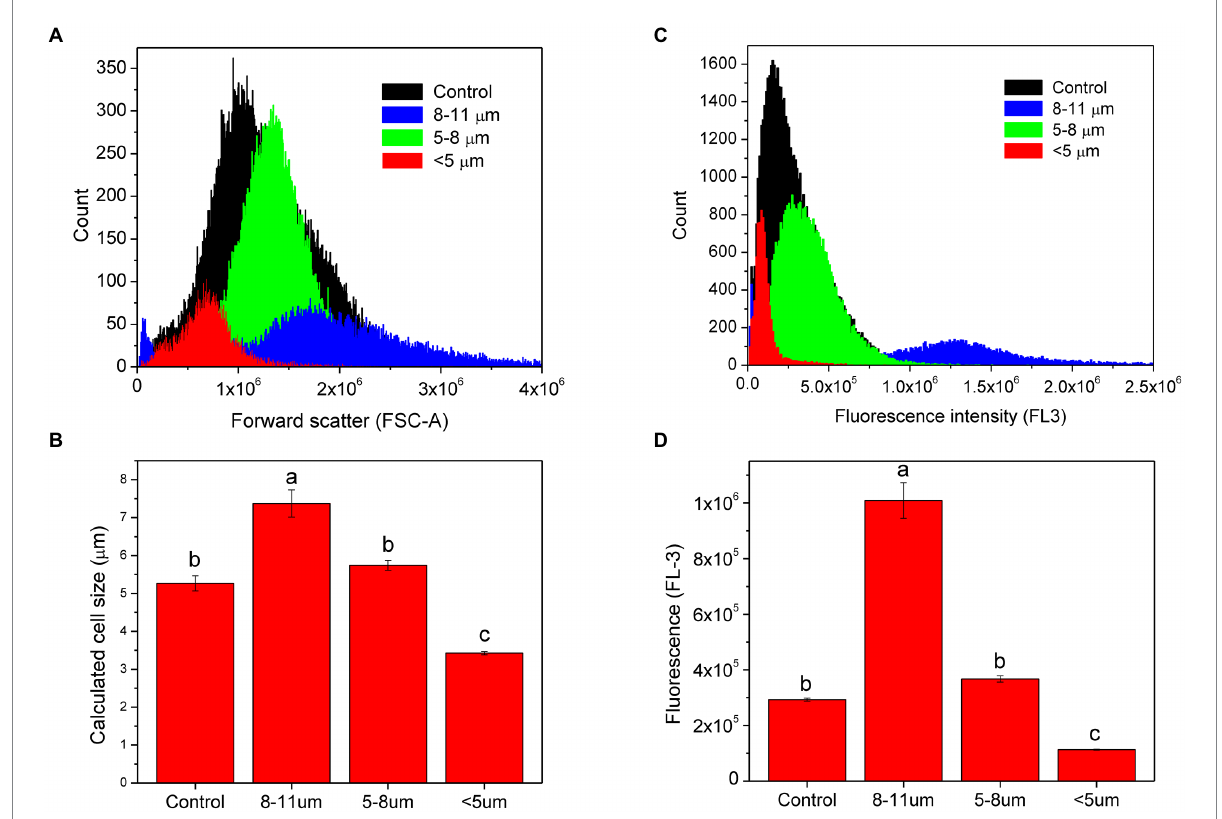
FIGURE 4 Analysis of isolated subpopulations of C. priscuii cells using flow cytometry. Overlay histogram of forward scatter channel (FSC-A) analysis for all cell fractions (A) . Estimation of cell size using mean FSC-A values and bead calibration (B) . Mean (± SE, n = 3) calculated sizes with different letters indicate significant difference, as determined by Tukey’s HSD ( p < 0.01). Combined histograms of FL-3 (>670 nm long-pass filter), measuring red chlorophyll fluorescence (C) and the corresponding mean FL-3 values (± SE; Tukey’s HSD, p < 0.01; D